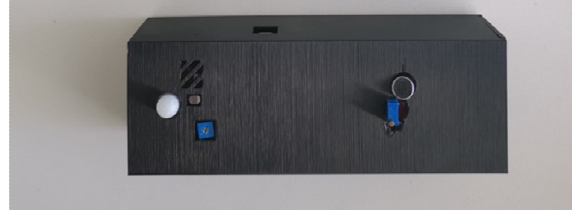
Figure 2. The developed acceleration data logging system.